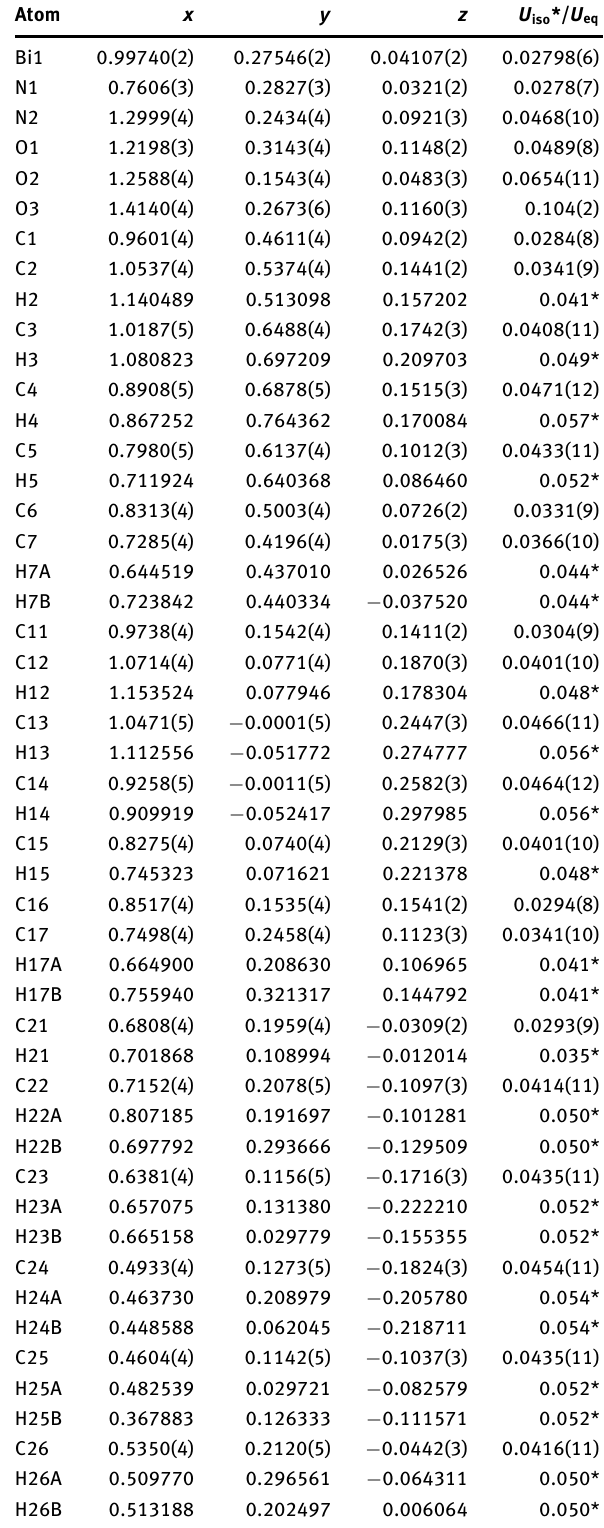
Table 2: Fractional atomic coordinates and isotropic or equivalent isotropic displacement parameters (Å 2